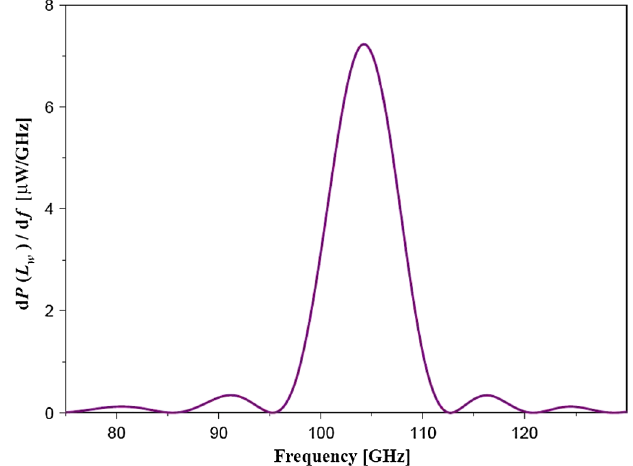
FIG. 1. Power spectral density of spontaneous emission for typical